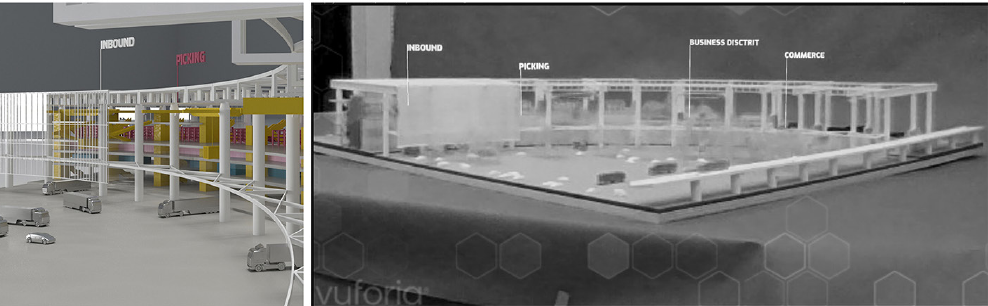
Fig. 9 Bertola, G., The Augmented Reality Project. Model Target creations on Vuforia® and the project on the Unity® platform (the recognition of the model target following the overlapping of the real model and the appearance of the Child object in AR) ,